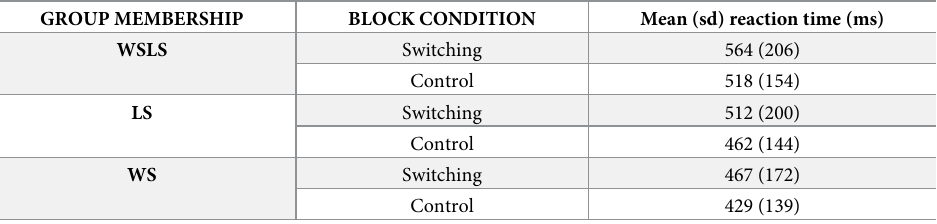
Table 1. Mean reaction times (milliseconds, SD in brackets) for each strategy group and block